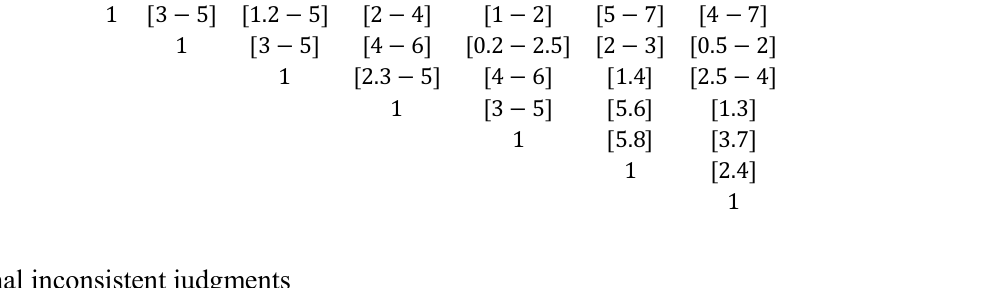
7-dimensional inconsistent